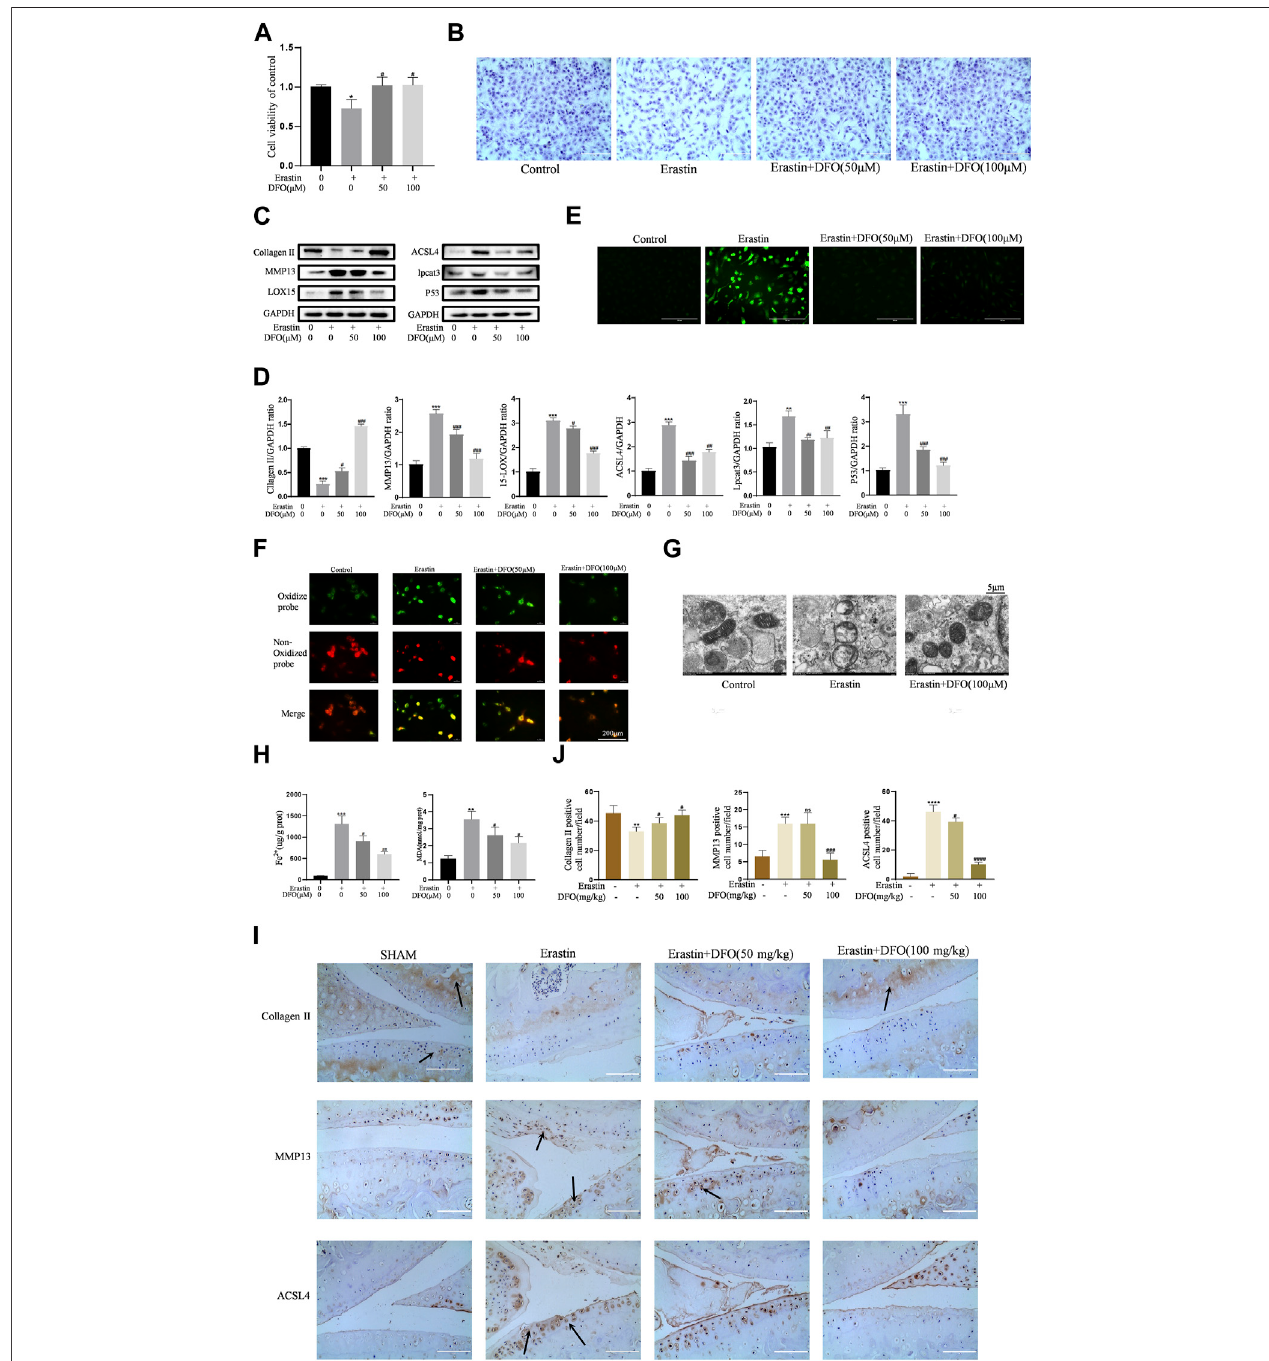
FIGURE 5 | DFO alleviated chondrocytes ferroptosis and OA progress induced by erastin. (A,B) Cell viability determined by CCK-8 assay and toluidine blue staining. (C,D) The protein expression levels of collagen Ⅱ , MMP13, ACSL4, LOX15, lpcat3, and P53 when treated by Erastin (5 μ M) with 50 and 100 μ M DFO or equa volume of DMSO were detected by Western blot, and band density ratios of collagen Ⅱ , MMP13, ACSL4, LOX15, lpcat3, and P53 to GAPDH in the Western blots were quanti fi ed bydensitometry ( n =3). (E) IntracellularROSleveldetectedbyDCFH-DA fl uorescent probe (scale bar:200 µm). (F) Intracellularlipid-ROS leveldetected byC11BODIPY fl uorescentprobe(scalebar:200 µm).Red,reducedformofC11-BODIPY;green,oxidizedformofC11-BODIPY. (G) Theultrastuctureofmitochondria observed via transmission electron microscopy(scale bar: 5 µm). (H) The intracellular level ofMDA and Fe2+ was determined using the MDA assaykit and iron assay kit n = 3). (I) The collagen Ⅱ , MMP13, and ACSL4 expression levels in the cartilage samples were measured using immunohistochemistry staining. Dotted arrows indicate positive cells for MMP13 and ACSL4 and positive staining of collagen Ⅱ (scale bar: 100 µm). (J) Quanti fi cation of MMP13- and ACSL4-positive cells and collagen Ⅱ – positive staining in vivo. * p < 0.05 versus control or the sham group, ** p < 0.01 versus control or the sham group, *** p < 0.001 versus control or the sham group,